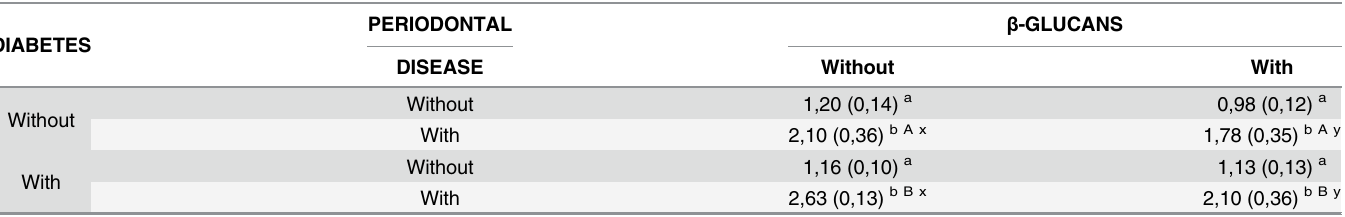
A,B Means followed by different letters in columns indicate signi fi cant differences between groups with and without diabetes by F test (p < 0,05). a,b Means followed by different letters in columns indicate signi fi cant differences between groups with and without periodontal disease by F test (p < 0,05). x,y Means followed by different letters in lines indicate signi fi cant differences between groups with and without β -glucan ingestion by F test (p <